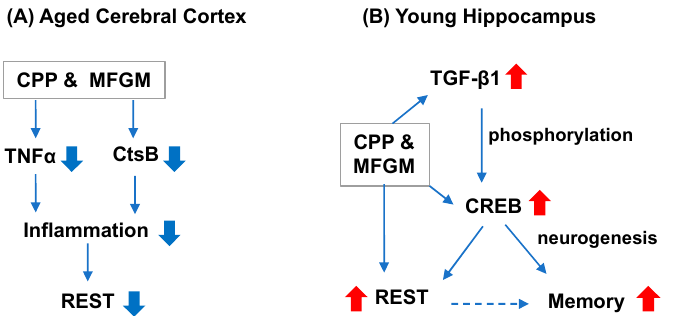
Figure 7. Effects of CPP and MFGM in the cerebral cortex of aged SAMP8 mice ( A ), and in the hippocampus of young mice ( B ). Blue arrows indicate a decrease and red arrows indicate an in- crease.